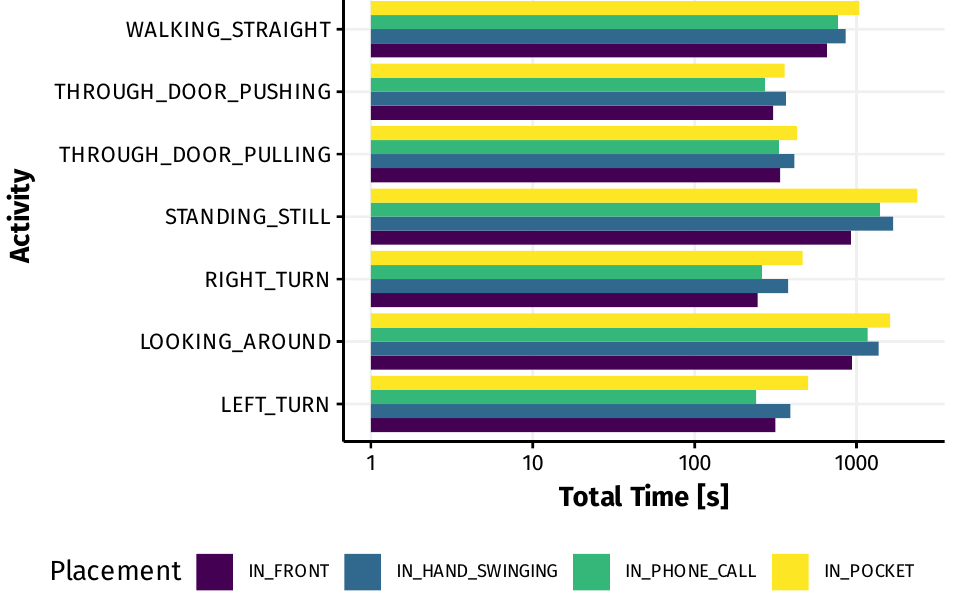
Figure 2. Amount of data for each combination of activity and device placement.